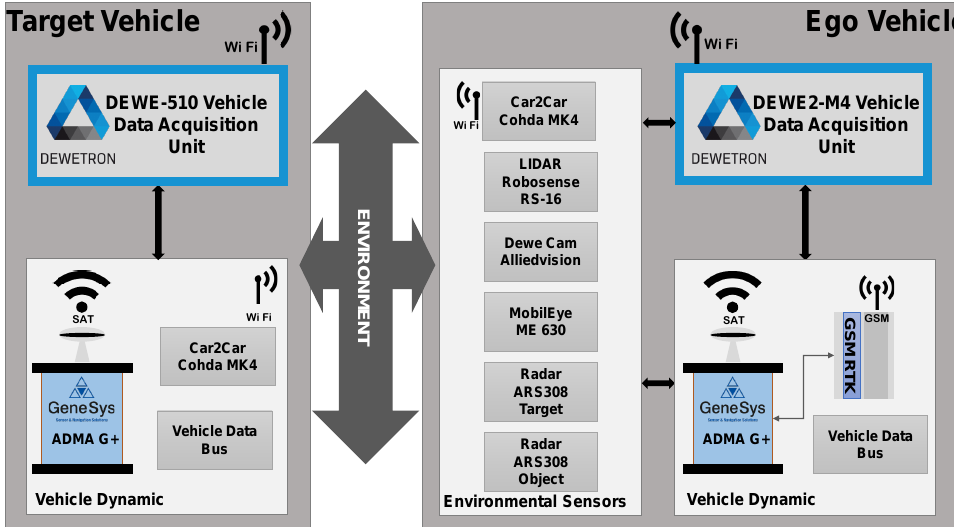
Figure 3. Schematic diagram of the measurement